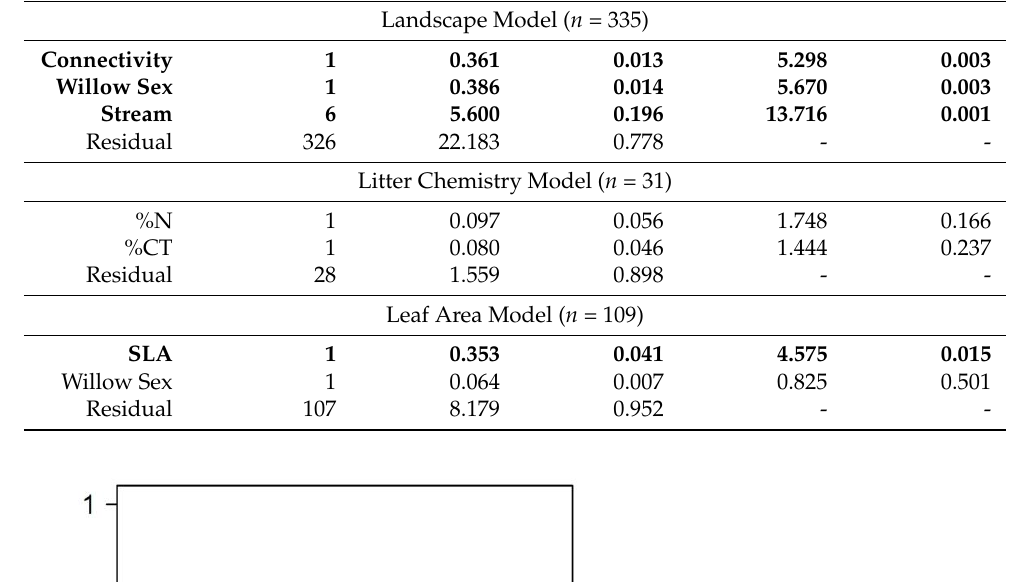
Table 2. Results of three permutational MANOVA (PERMANOVA) tests for community dissimilarity as a response to changes in the overall landscape, chemistry, and leaf area factors (AIC model selection in Table S4). Factors not present in this table were not part of the best model. Three separate models were used due to differences in the number of observations for each subset of data. Differences found for continuous variables were analyzed using NMDS analyses in Figures 3 and S1. Bolded rows indicate significant effects at α = 0.05. Abbreviations: df is degrees of freedom, SS is the sum of squares, R 2 is the correlation coefficient, F is a pseudo- F test statistic, and p is the null model probability parameter.